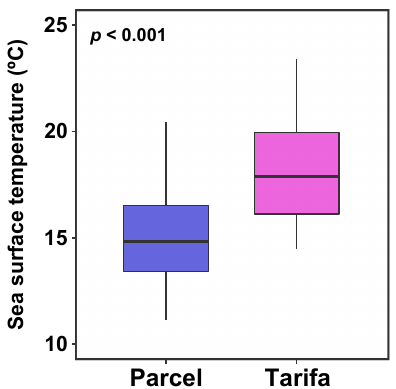
Figure 2. Sea surface temperature at Parcel and Tarifa over a 10-year period (2009–2018). Boxplot bar is the median, box is the interquartile range (IQR), and whiskers are the maximum and minimum values within the 1.5 × IQR of the hinge ( n =